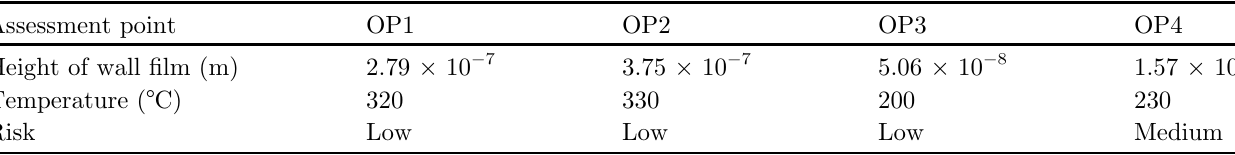
Table 7. Crystallization risk at the